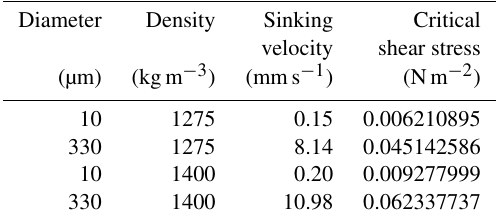
Table A1. Sinking velocities and critical shear stress in the model at 10 ◦